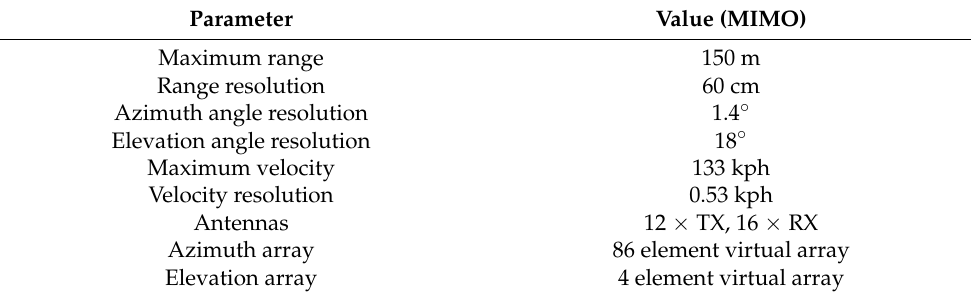
Figure 5. The structure of the imaging radar. Table 1. The parameters of the imaging